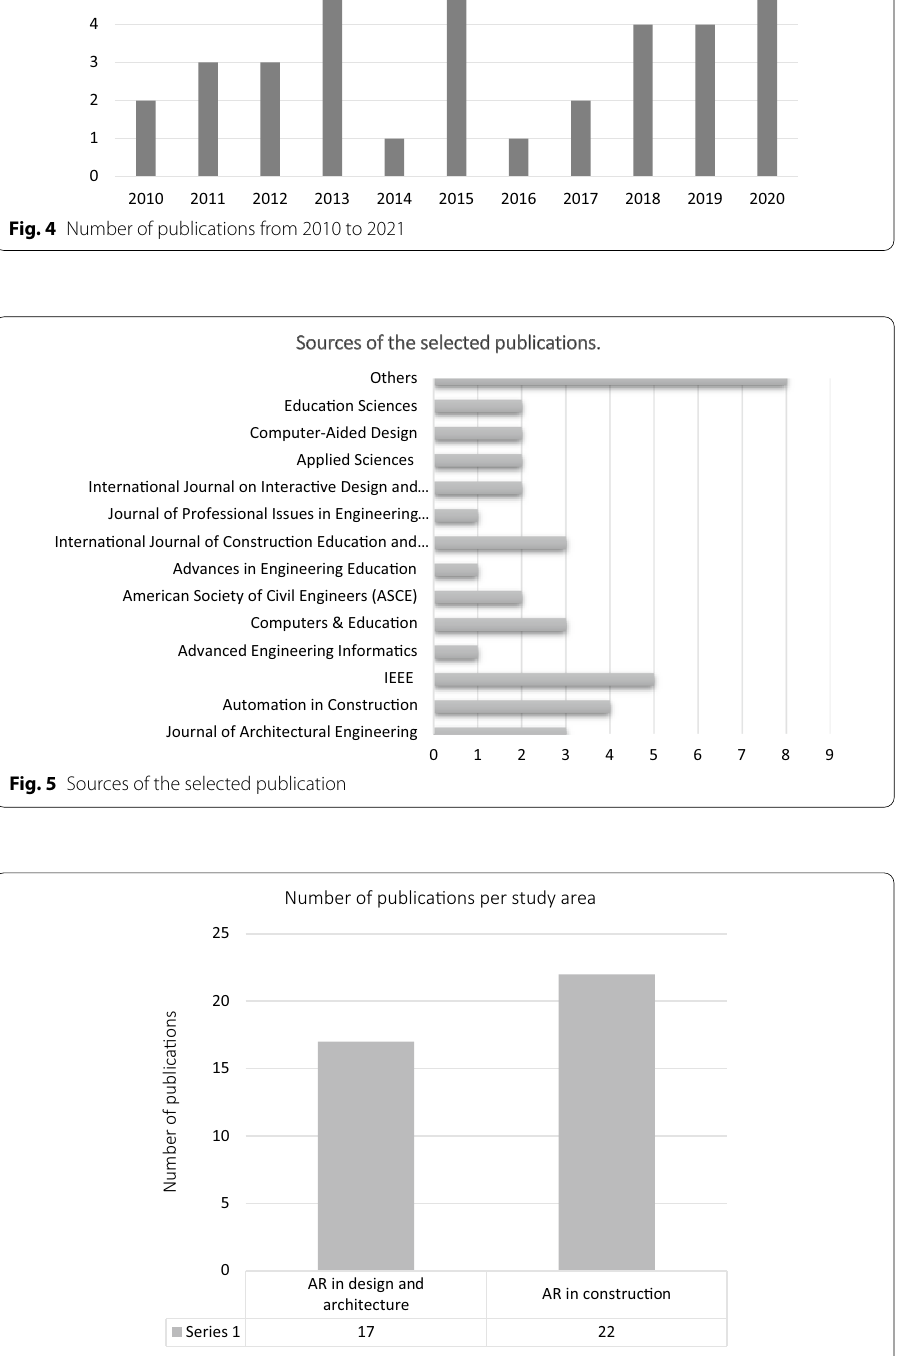
Fig. 6 Number of publications per study